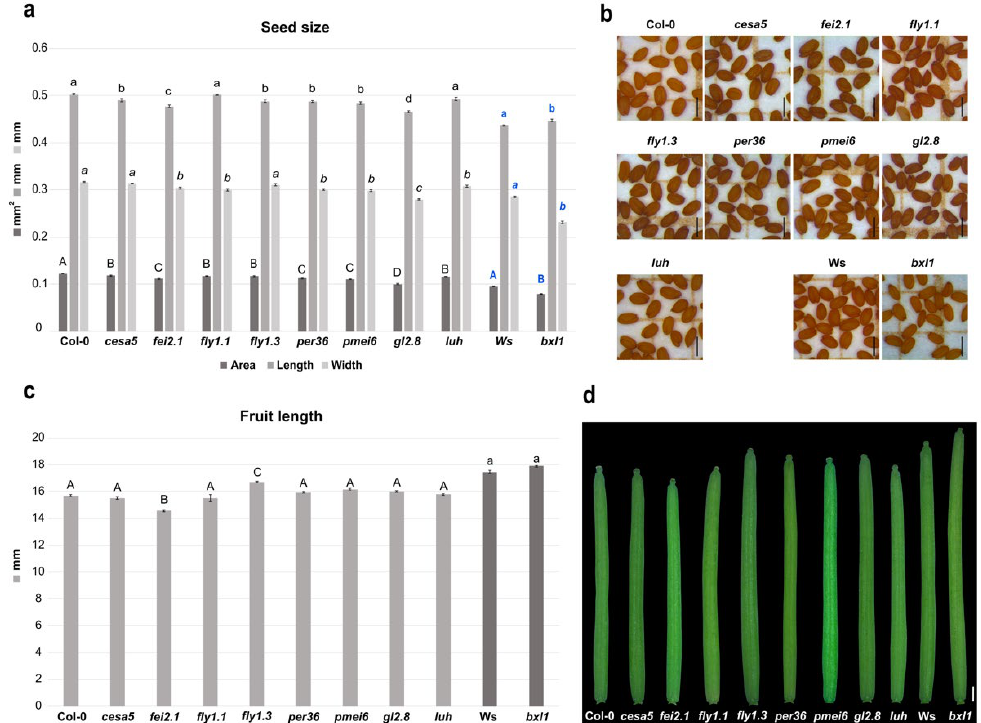
Figure 1. Effects of the cell wall mutations in seed and silique development. ( a ) Histogram representing seed size of the cell wall mutants, with mean of the seed area (mm 2 ), length (mm), and width (mm); Error bars indicate the standard error (SE) of one representative biological replicate of n = 50 seeds. Statistical analyses were performed using ANOVA, followed by Tukey’s HSD test. Different letters indicate statistically significant differences ( p < 0.01) (WT versus the other genotypes). ( b ) Stereomicroscope images of seeds from the cell wall mutants. Scale bar = 0.5 mm. ( c ) Histogram representing the mean of the silique length of the cell wall mutants; error bars indicate the SE of one representative biological replicate of n = 10 siliques. Statistical analyses were performed using ANOVA followed by Tukey’s HSD test; different letters indicate statistically significant differences ( p < 0.01) (WT versus the other genotypes). ( d ) Stereomicroscope images of the siliques from cell wall mutants. Scale bar = 1 mm.